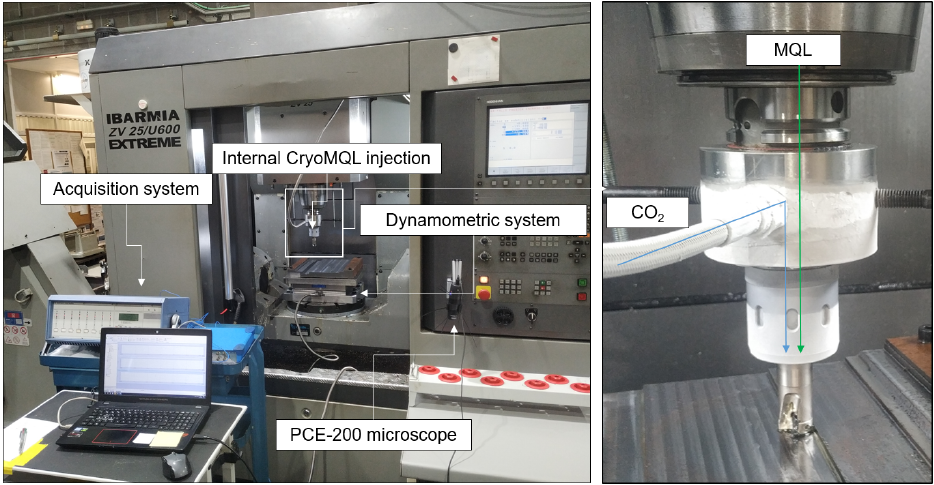
Figure 1. Milling set